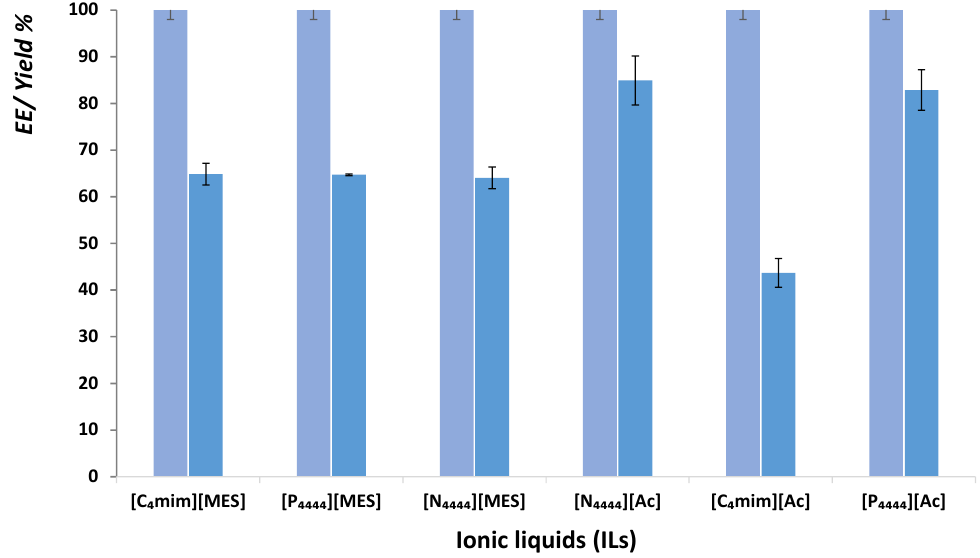
Figure 3. Extraction efficiencies (EE% ) ( ◼ ) and yield ( Yield% ) ( ◼ ) of bovine serum albumin in the ionic-liquid-rich phase of the studied aqueous biphasic systems composed of 35 wt% of ionic liquid + 20 wt% K 2 HPO 4 /KH 2 PO 4 buffer at pH 7.